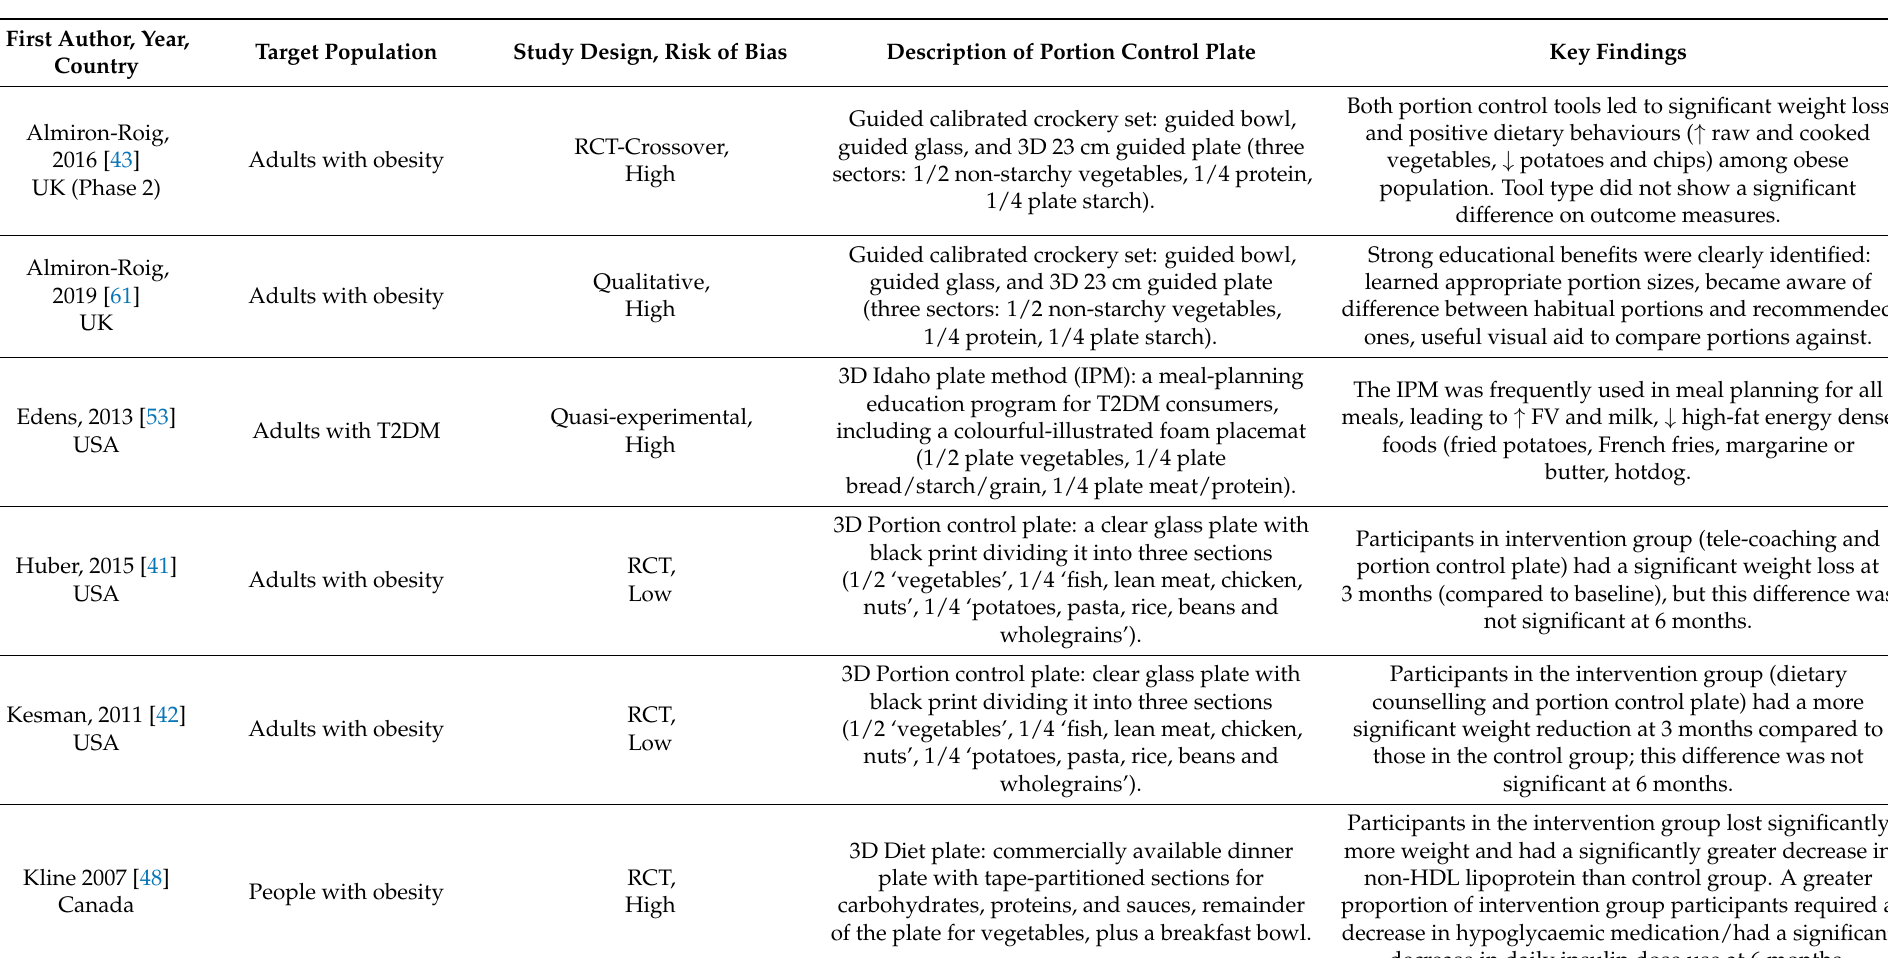
Table 3. Studies reporting the use of portion control plate for weight loss interventions and type 2 diabetes